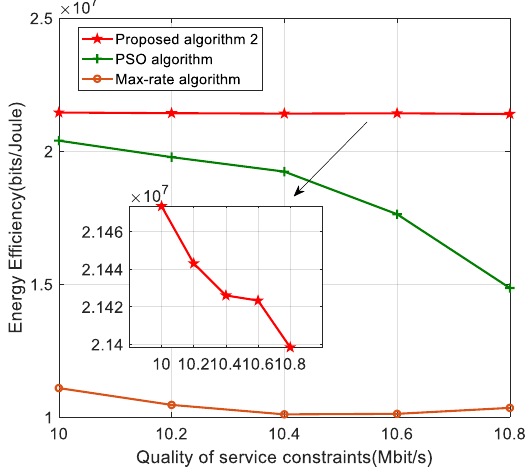
Figure 6. energy efficiency versus the QoS for different algorithms. Figure 6. Energy efficiency versus the QoS for different